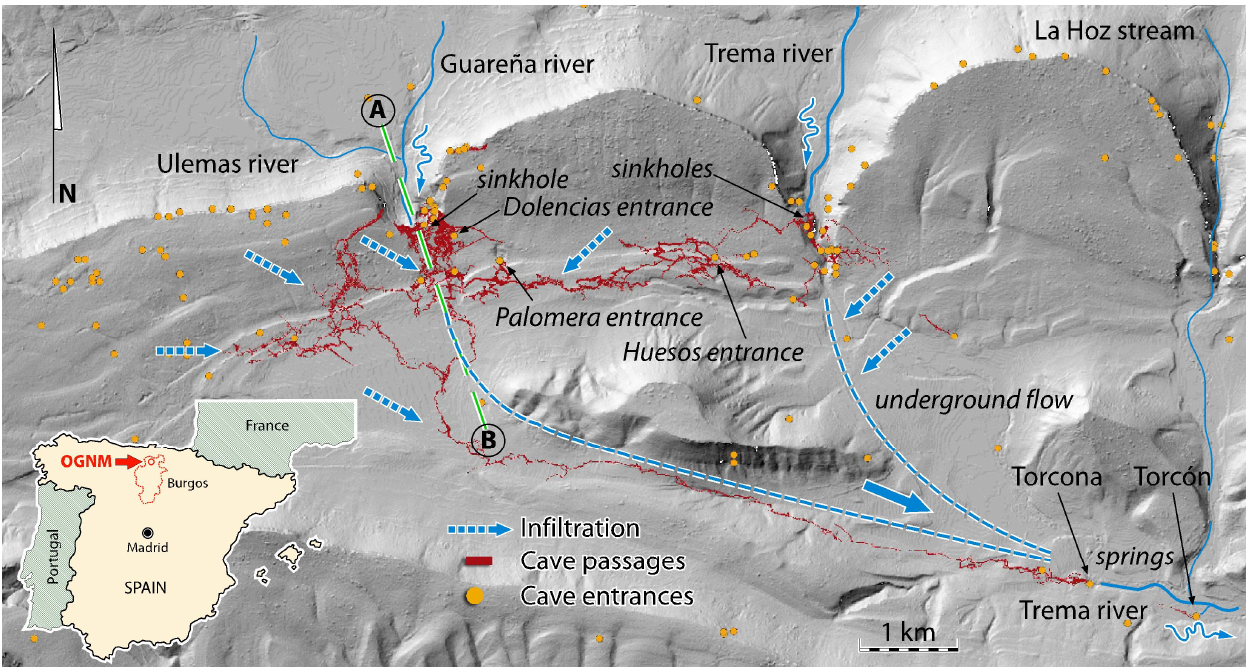
Figure 3. Location of caves, underground galleries, flows, and drainages on a digital elevation model of the OGNM